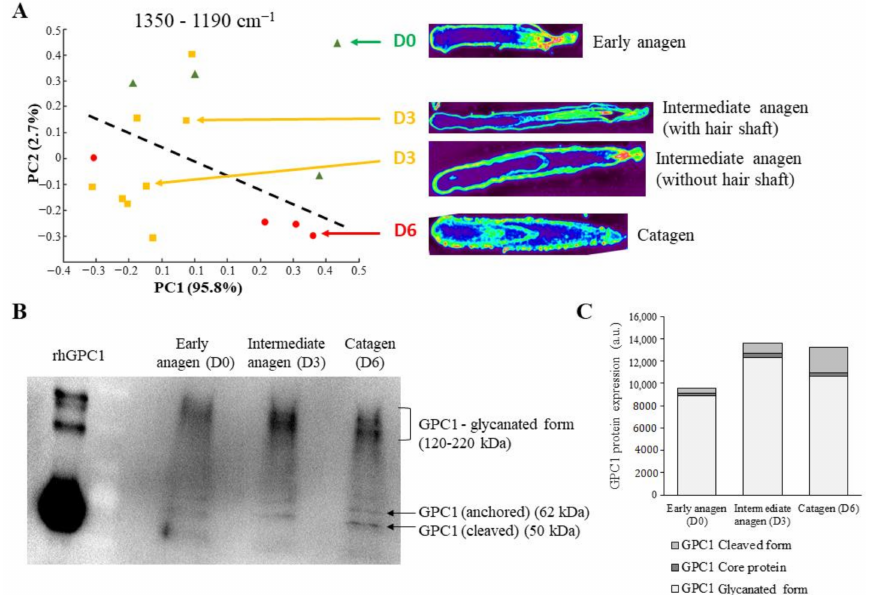
Figure 7. Discrimination of hair follicles by PCA compared to GPC1 expression during the hair growth cycle. ( A ) PCA score plot performed on normalized mean spectra of the ORS region 4 in the 1350–1190 cm − 1 range and carried out on early anagen D0, intermediate anagen D3, and catagen D6 hair follicles. ( B ) GPC1 protein expression analyzed by Western immunoblotting of early anagen D0, intermediate anagen D3, and catagen D6 hair follicles. ( C ) Quantification of each GPC1